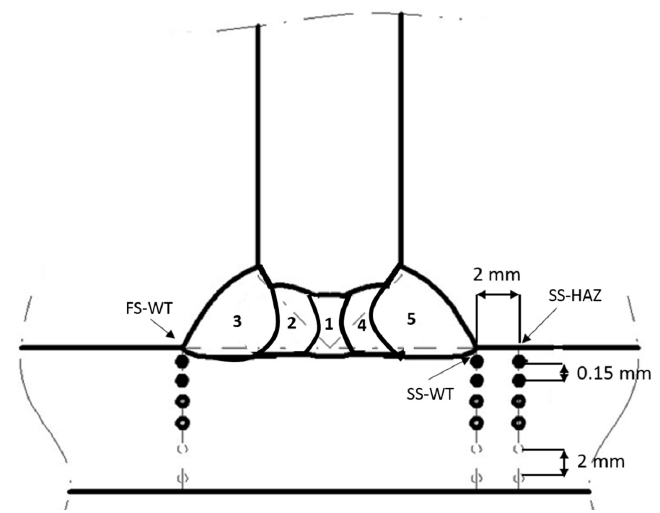
Figure 4. Location of measurement positions. Distance between two points are 0.15 mm close to the surface and gradually increases to 2 mm at greater depth.